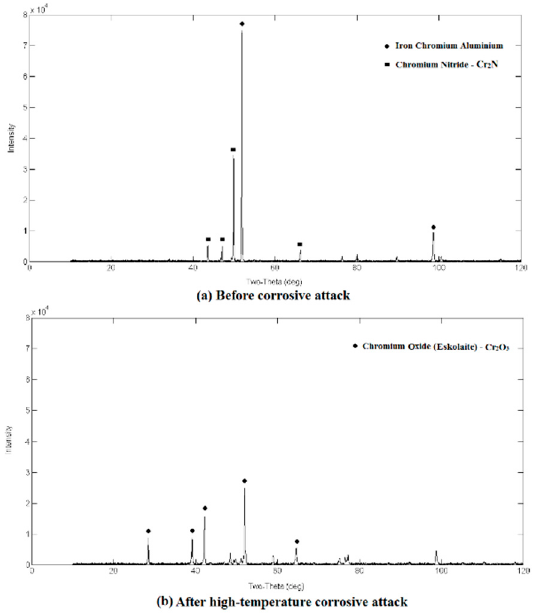
Figure A32. Qualitative XRD analysis of the surface of 316-Cr ( a ) before corrosive attack, ( b ) high-temperature corrosive attack.